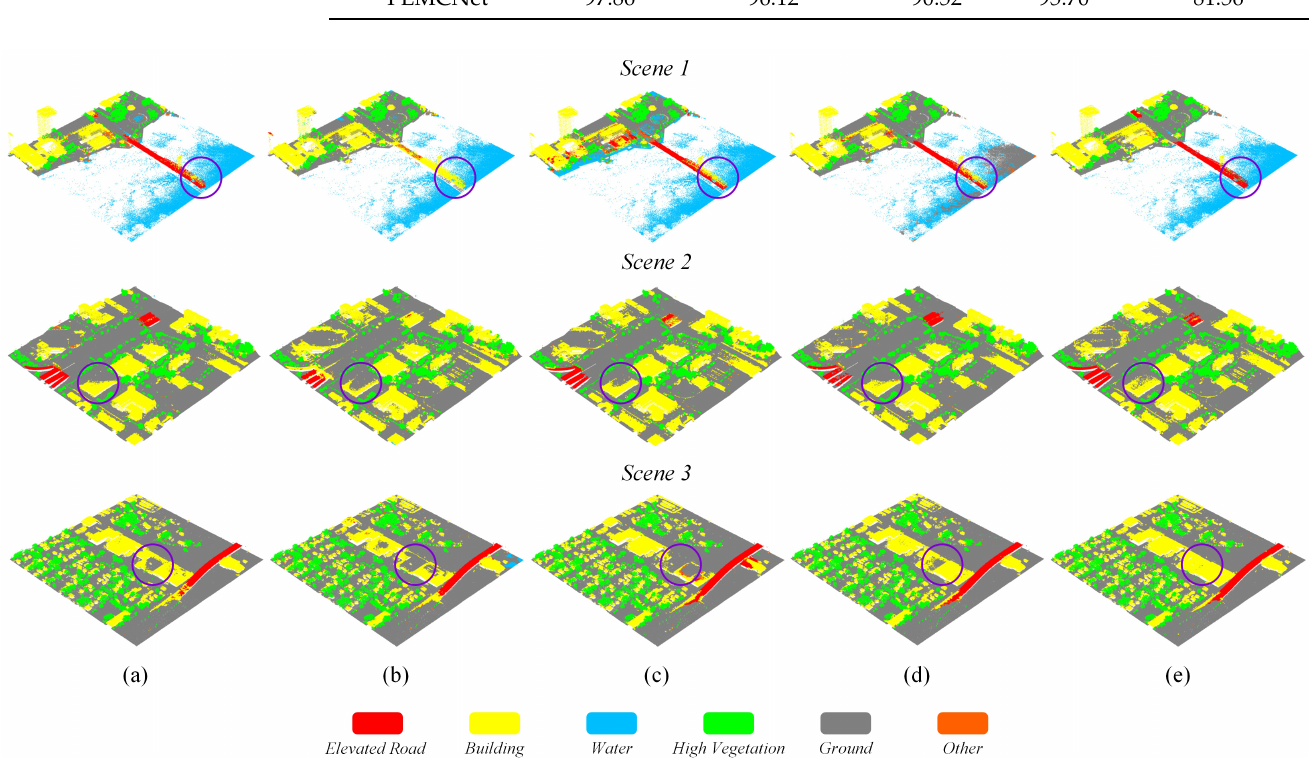
Figure 3. Classification results of five different approaches on the test set of US3D dataset: ( a ) PointNet++ (MSG); ( b ) PointSIFT; ( c ) PointConv; ( d ) LSANet; ( e )